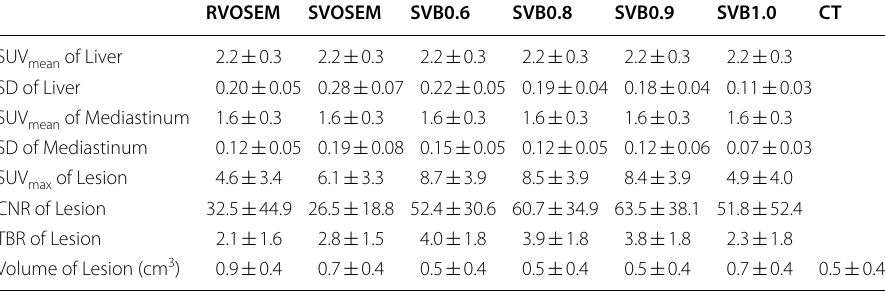
Table 2 Quantitative results of the patient study